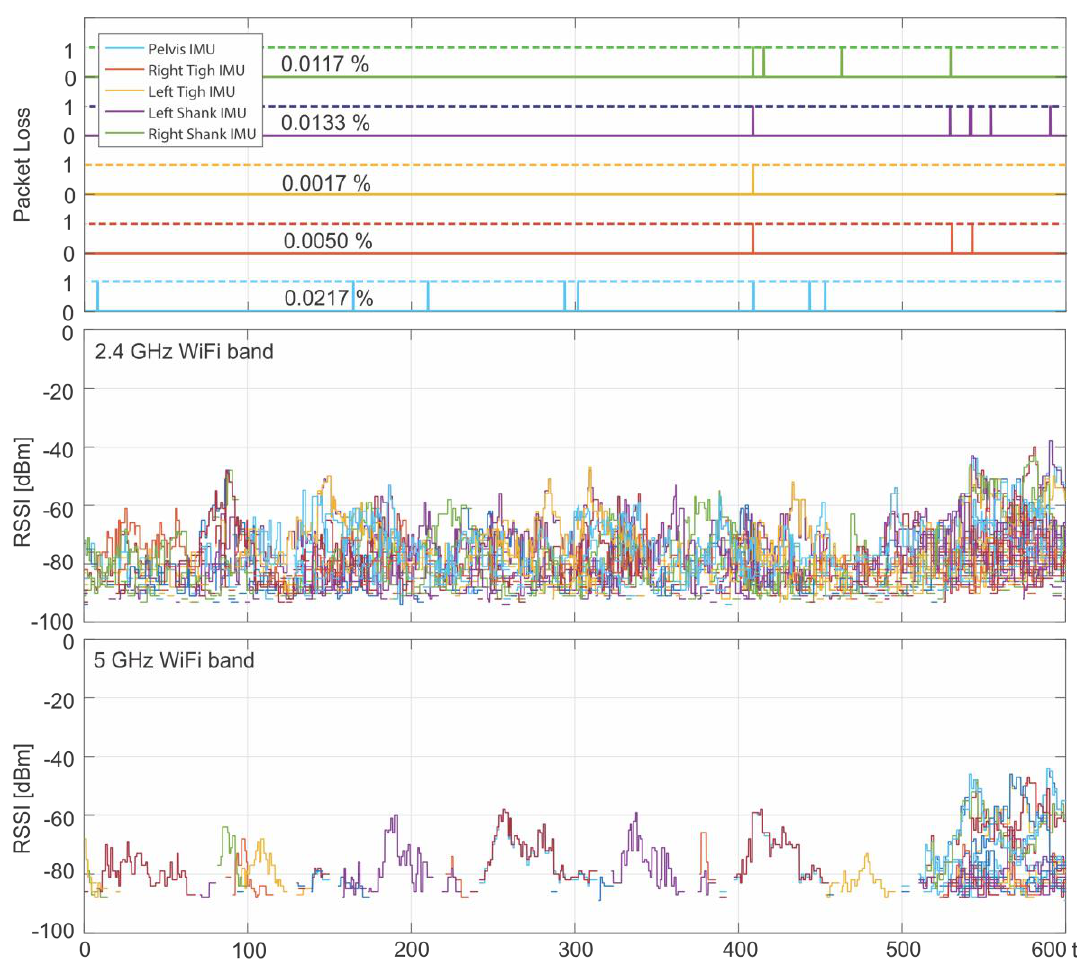
Figure 7. Top plot shows the measured packet loss for the IMU units attached to the pelvis, right/left thigh, and right/left lower leg. The middle plot shows the RSSI signal levels for various 2.4-GHz Wi-Fi band channels. Bottom diagram shows the RSSI signal levels for various 5-GHz Wi-Fi band channels.